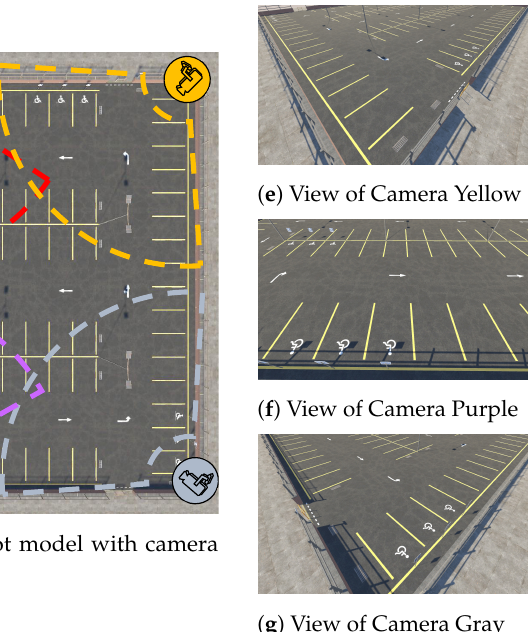
Figure 7. Aerial view and different views of cameras. ( d ) shows the direct aerial view image capture from 3D software, illustrating the positions and directions of the six cameras. ( a – c ) and ( e – g ) show the views of these